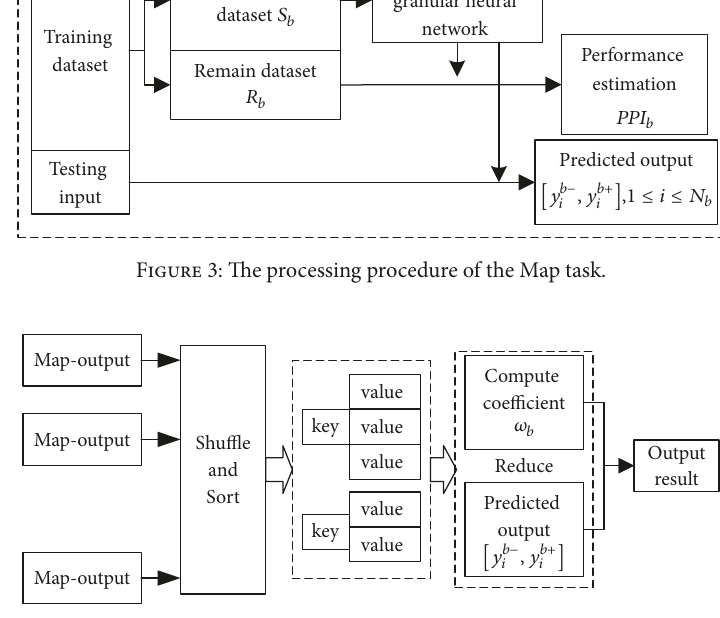
Figure 4: The architecture of the Map-Reduce programming